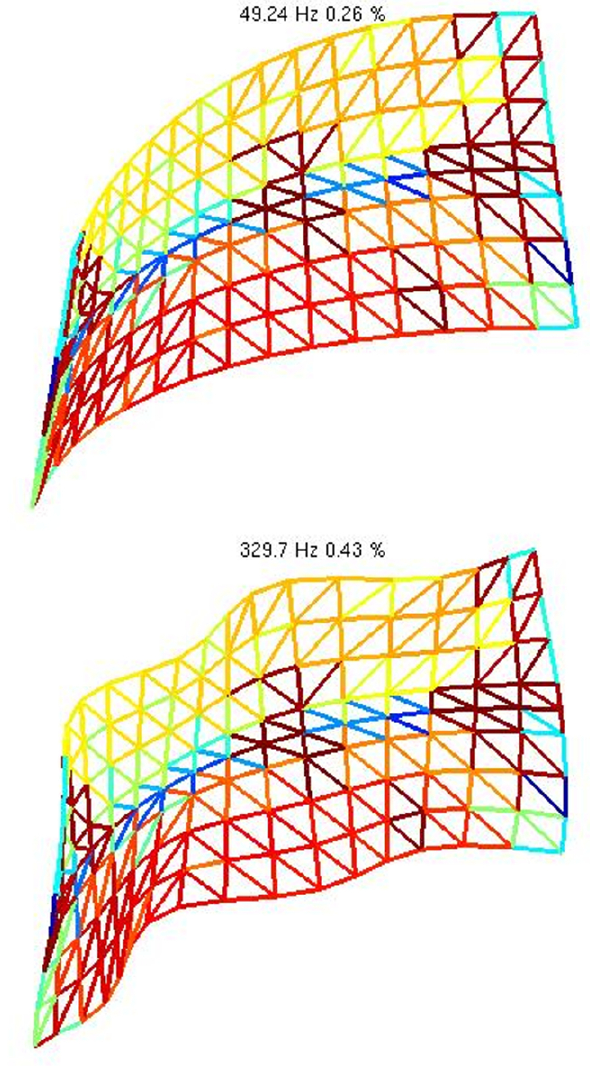
Figure 5: Experimental mode shapes